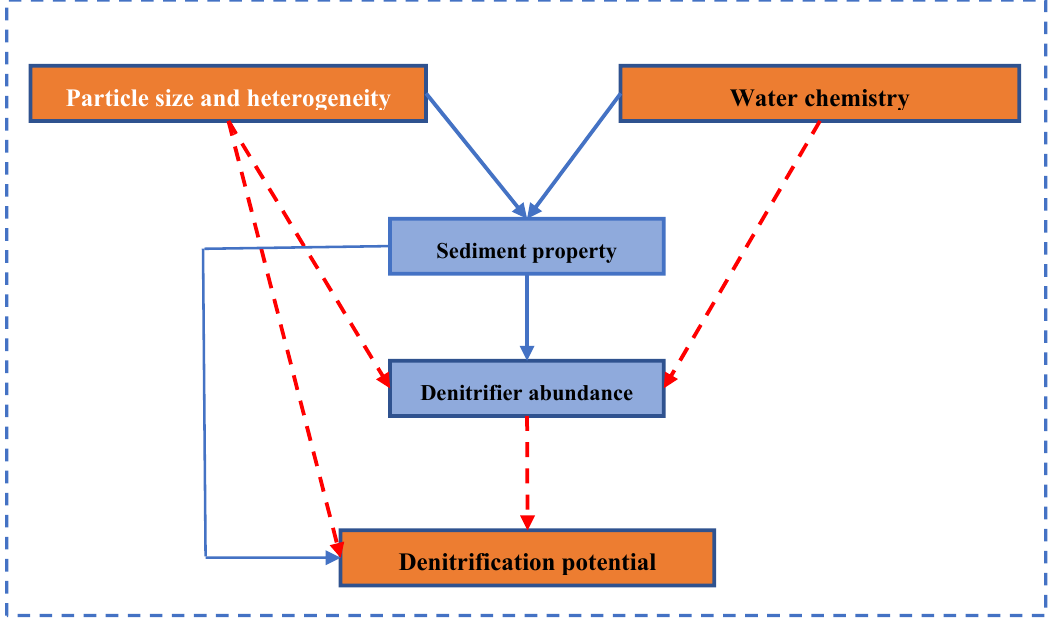
Figure 6. Schematic demonstrating that water chemistry, rather than particle size and heterogeneity, sediment properties, and function gene abundances, was the most important factor controlling the denitrification rates of permeable sandy sediments. Continuous and dashed arrows indicate significant and insignificant relationships. The width of arrows is proportional to the strength of relationships.